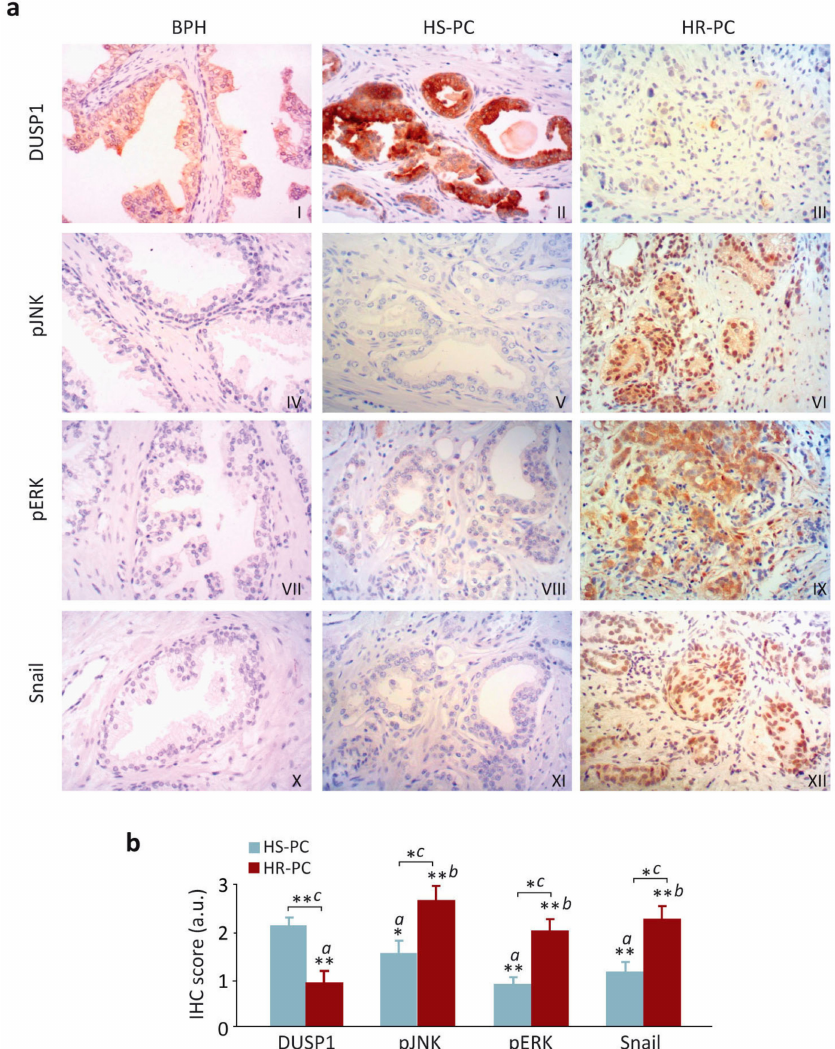
Figure 7. DUSP1 expression inversely correlates with Snail levels and activated JNK and ERK in human prostate samples. ( a ) Immunohistochemical analysis of expression levels of DUSP1 (I–III), phosphorylated JNK (pJNK, IV–VI), phosphorylated ERK (pERK, VII–IX) and Snail (X–XII) from hu- man prostate cancer samples. Micrographs were taken at 200 × magnification and show serial sections from the same gland stained with each one of the four used antibodies. ( b ) Immunohistochemical score for DUSP1, pJNK, pERK and Snail in samples from HS-PC and HR-PC. The statistical analysis was performed with One-way ANOVA and Dunnet ´ s multiple comparison test, and asterisks show the statistical significance of differences between the groups ( a: comparison with DUSP1 from HS-PC samples; b: comparison with DUSP1 from HR-PC samples; c: HS-PC vs HR-PC for each marker), * 0.01 < p < 0.05; ** 0.001 < p <